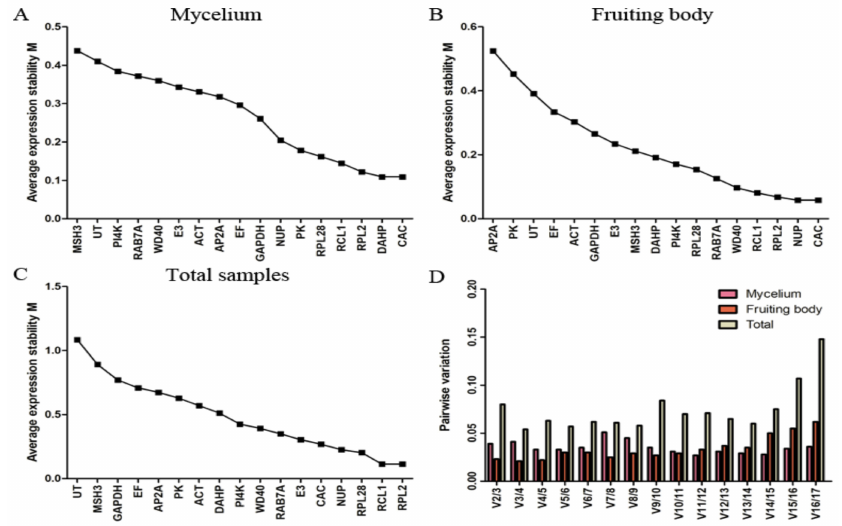
Figure 2. Expression stability and ranking of candidate reference genes determined by geNorm. ( A ) mycelium data set; ( B ) fruiting body data set; ( C ) all-sample data set; ( D ) pairwise variation (Vn/Vn + 1) for the optimal number of reference